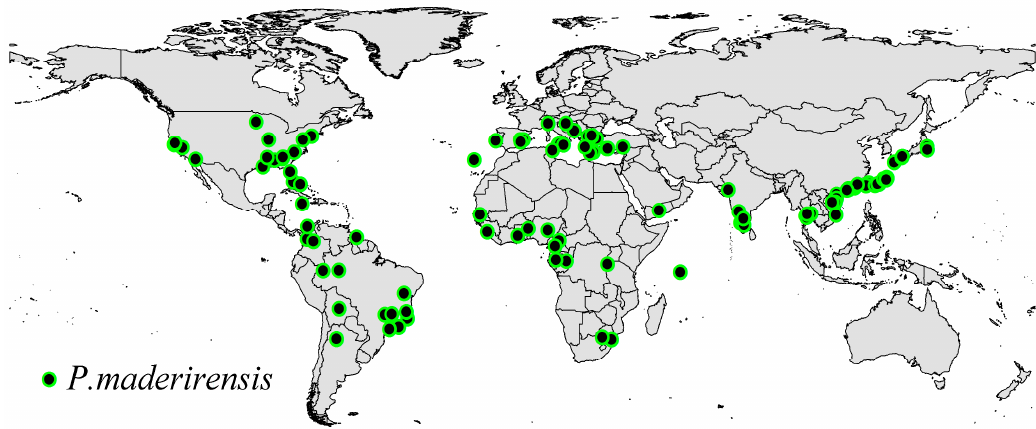
Figure 1. The occurrence sites used for the forecast of the potential distribution of P. madeirensis.